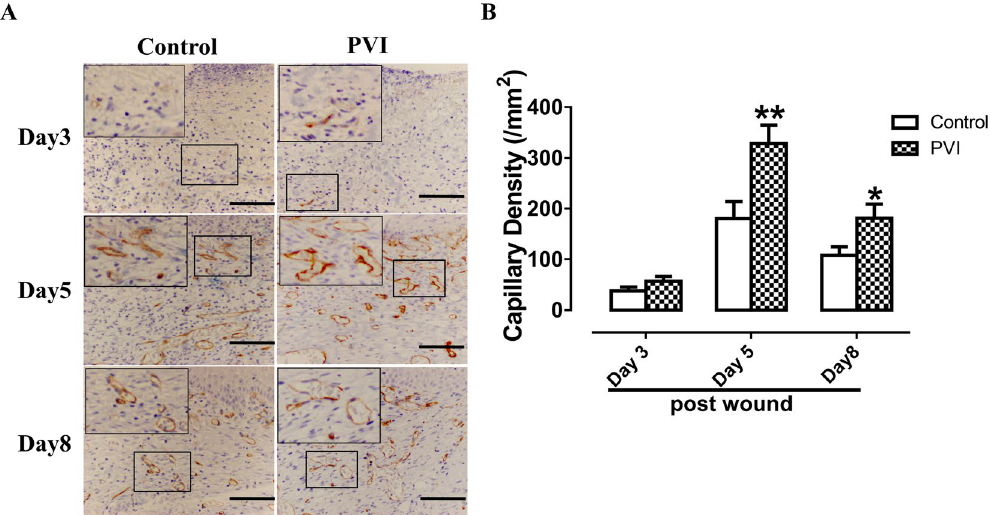
Figure 3. Povidone-iodine (PVI) treatment promoted wound neovascularization. ( A ) Representative immunohistochemical CD34 stained wound sections from a control and PVI treated rat. Scale bar = 50 μ m. ( B ) Semi-quantitative analysis of capillary density (/mm 2 ). Capillary density was assessed by counting the number of CD34 positive microvessels in high-power fields (40x). * p < 0.05, ** p < 0.01 vs control. Data are means ± S.D, n =